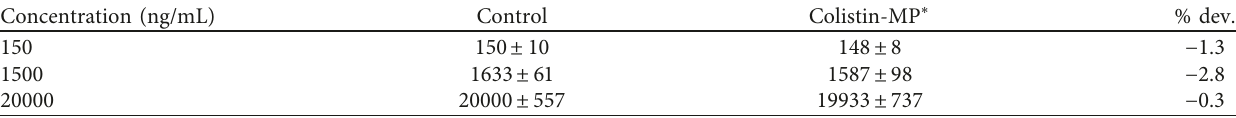
Table 5: Interference of potential concomitant drugs.